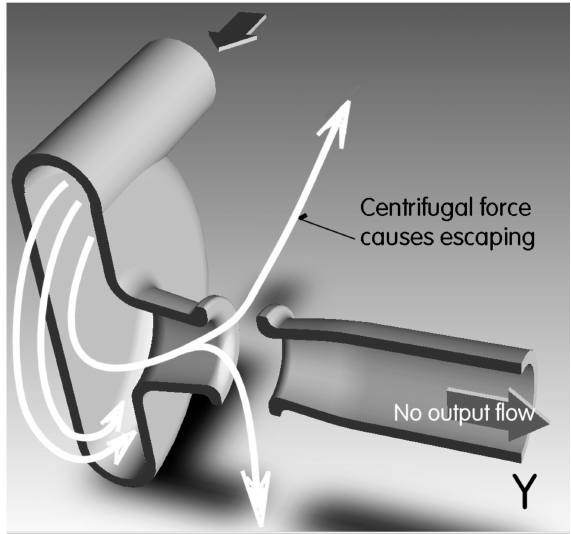
Figure 5. The pulse shaper from Figure 4 in the regime of rotation inside the vortex chamber. Output flow in Y is zero because the fluid escapes through the gap between the two